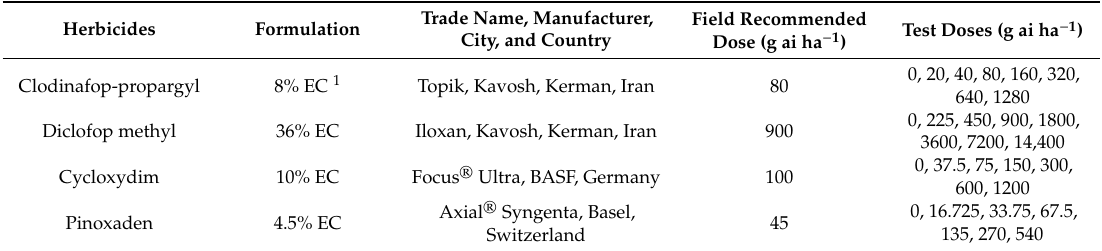
Table 1. Herbicide treatments applied for dose-response assays in a Phalaris brachystachys population. Herbicides